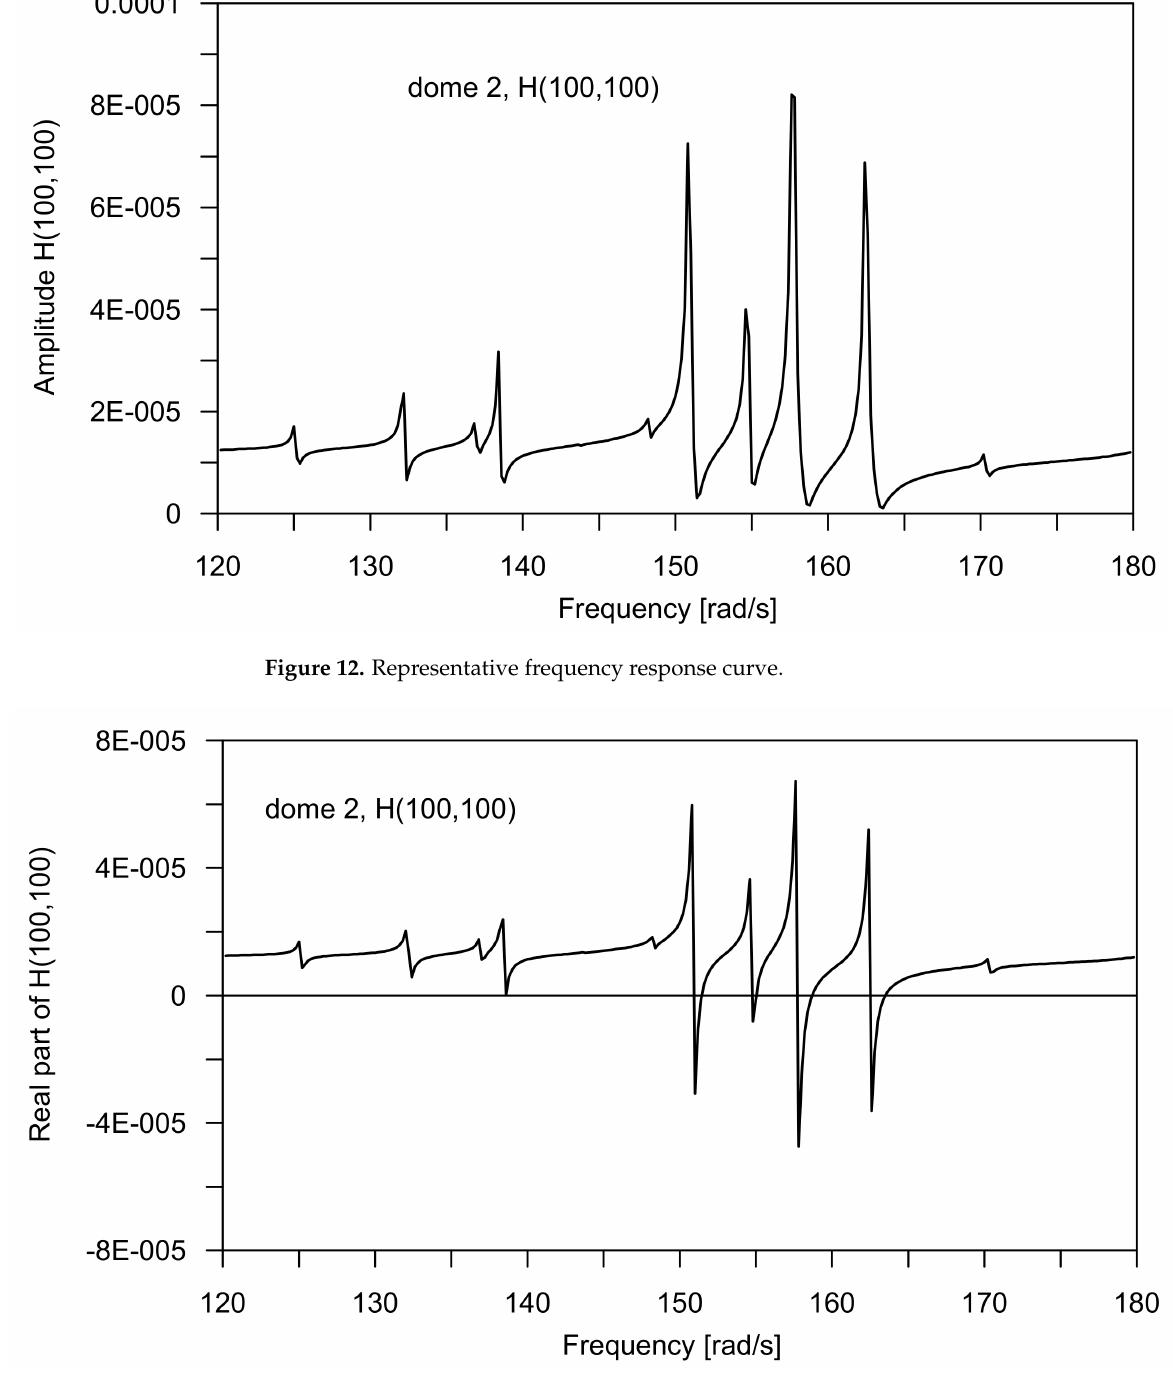
Figure 13. Real part of the representative frequency response